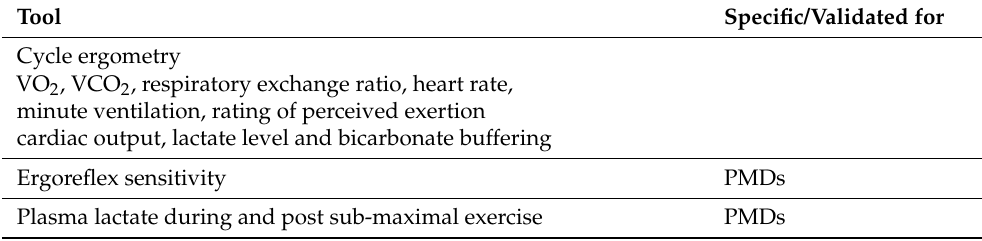
Table 2. Cont. Tool Specific/Validated